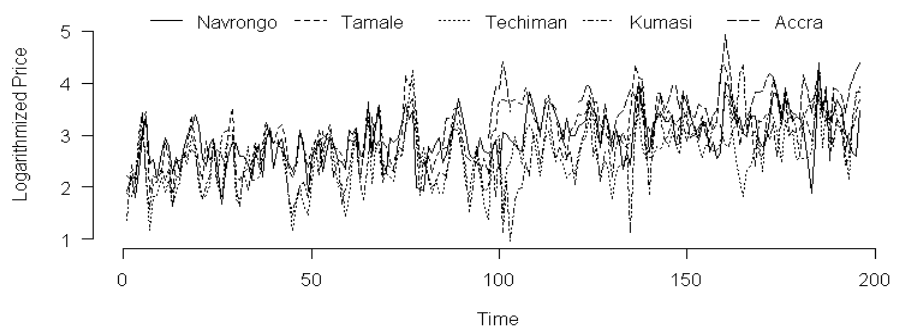
FIGURE 2: Low Frequency, Monthly Price Data (constant January 1997 in Ghana Cedi)